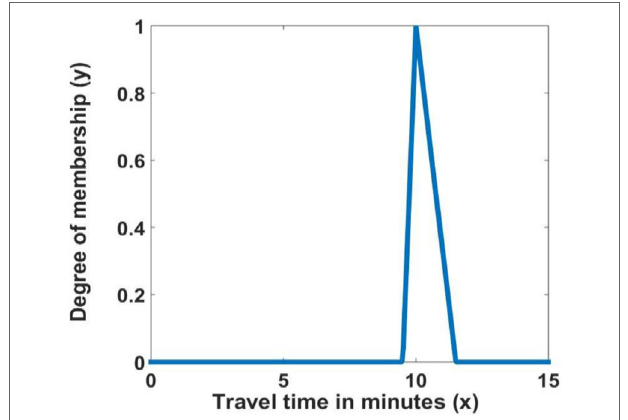
FigUre 2 | Travel time membership function.